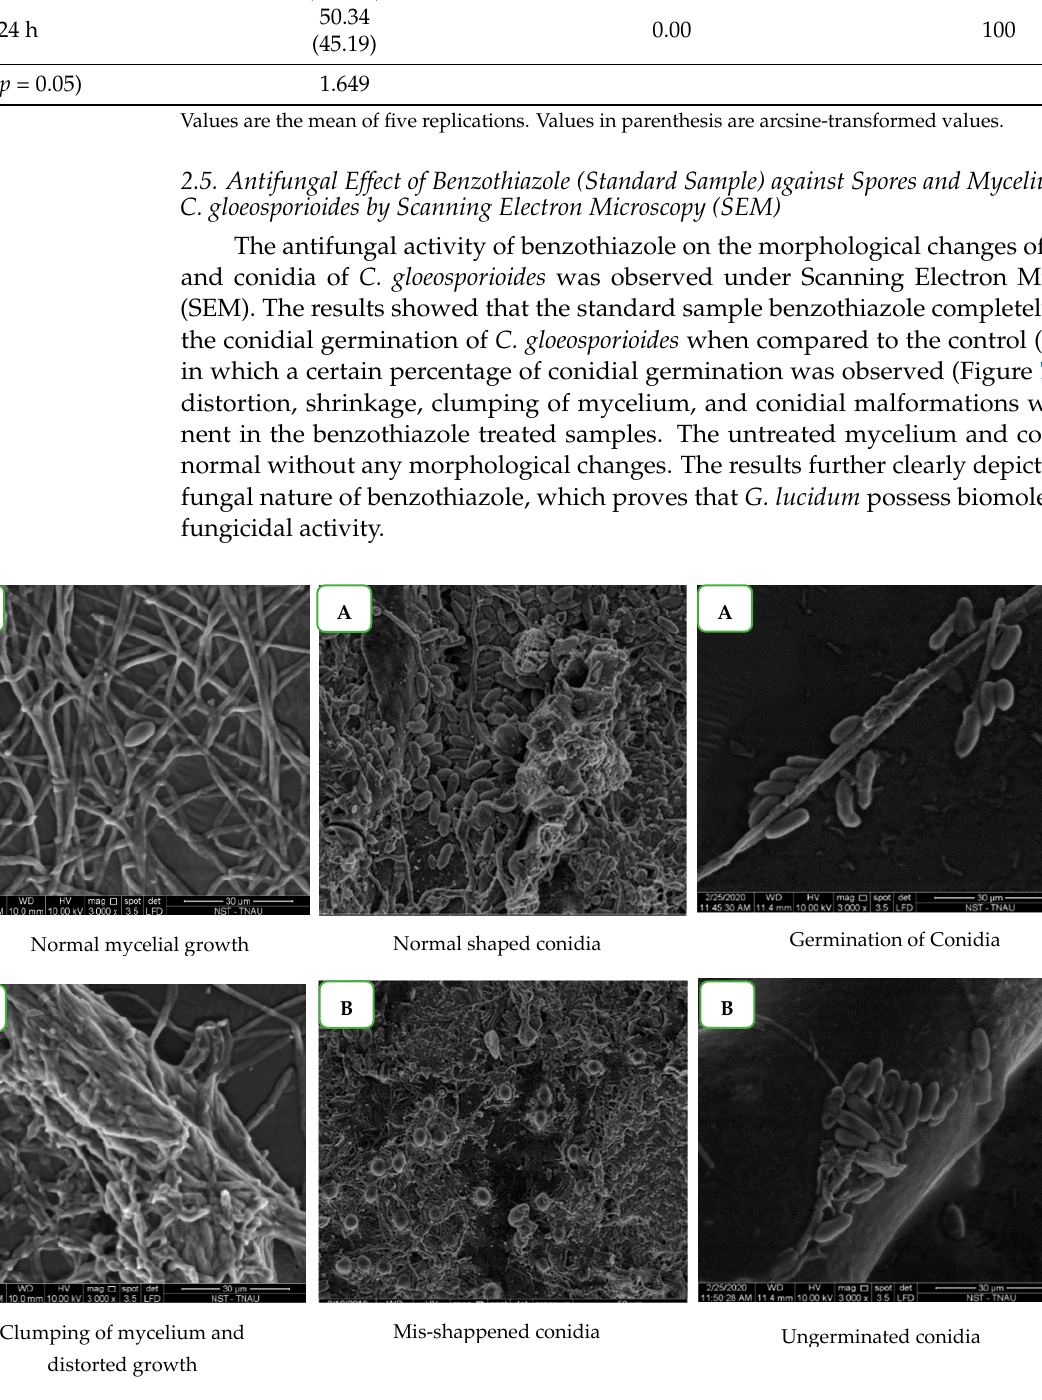
Figure 7. Effect of benzothiazole on germination of spores of C. gloeosporioides under Scanning Electron Microscopy (SEM). ( A ) Control. ( B ) Treatment.